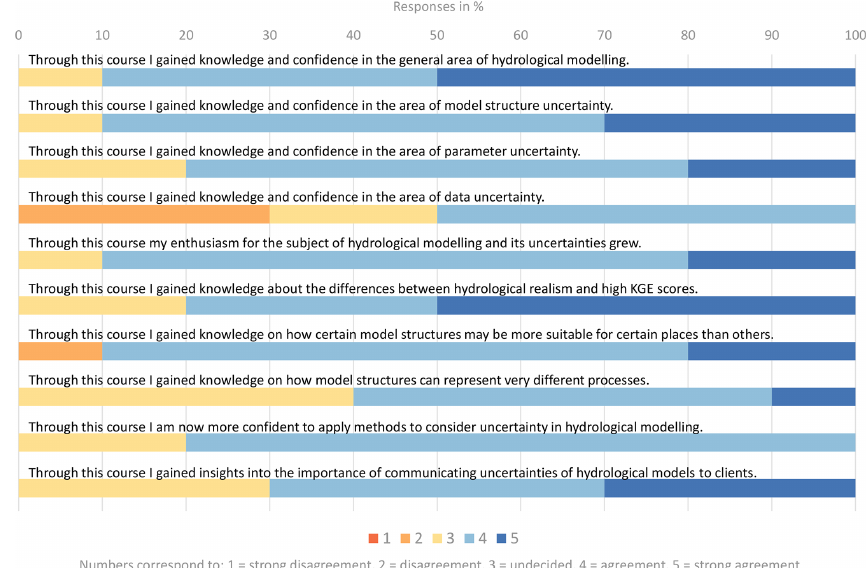
Figure 5. Responses to the feedback form distributed after the MARRMoT exercises. Only responses to the questions that had to be answered on a 1 to 5 scale are shown; responses to open questions are summarized in Sect. S3. A value of 1 indicates disagreement and 5 indicates agreement.